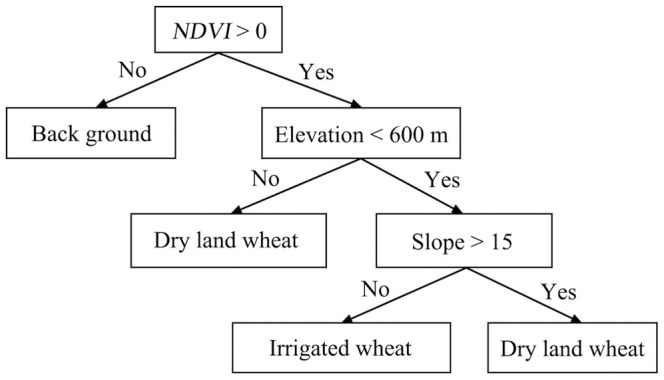
The classification image of decision tree of irrigated and dry land winter wheat.